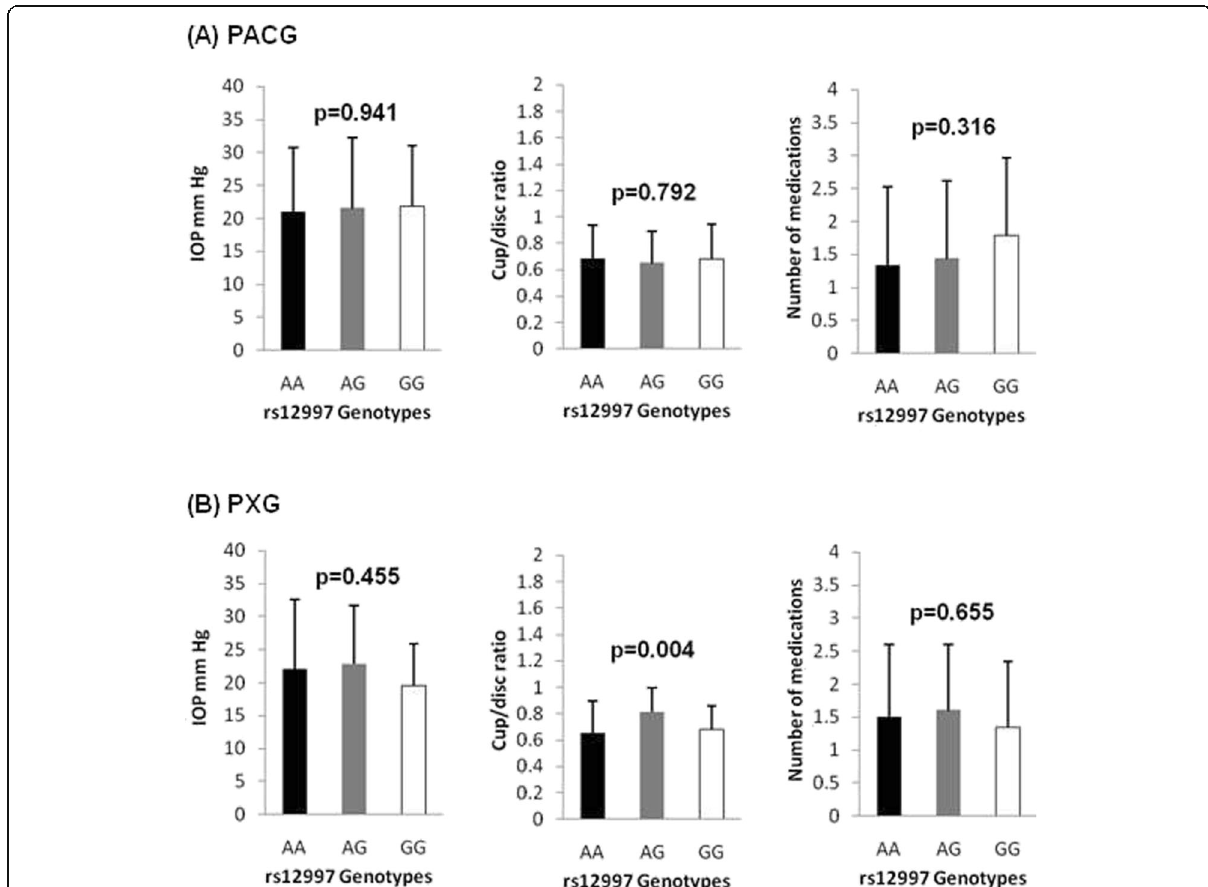
Fig. 2 Genotype effects of rs12997 variant on intraocular pressure (IOP), cup/disc ratio and number of antiglaucoma medication in ( a ) PACG and ( b ) PXG patient